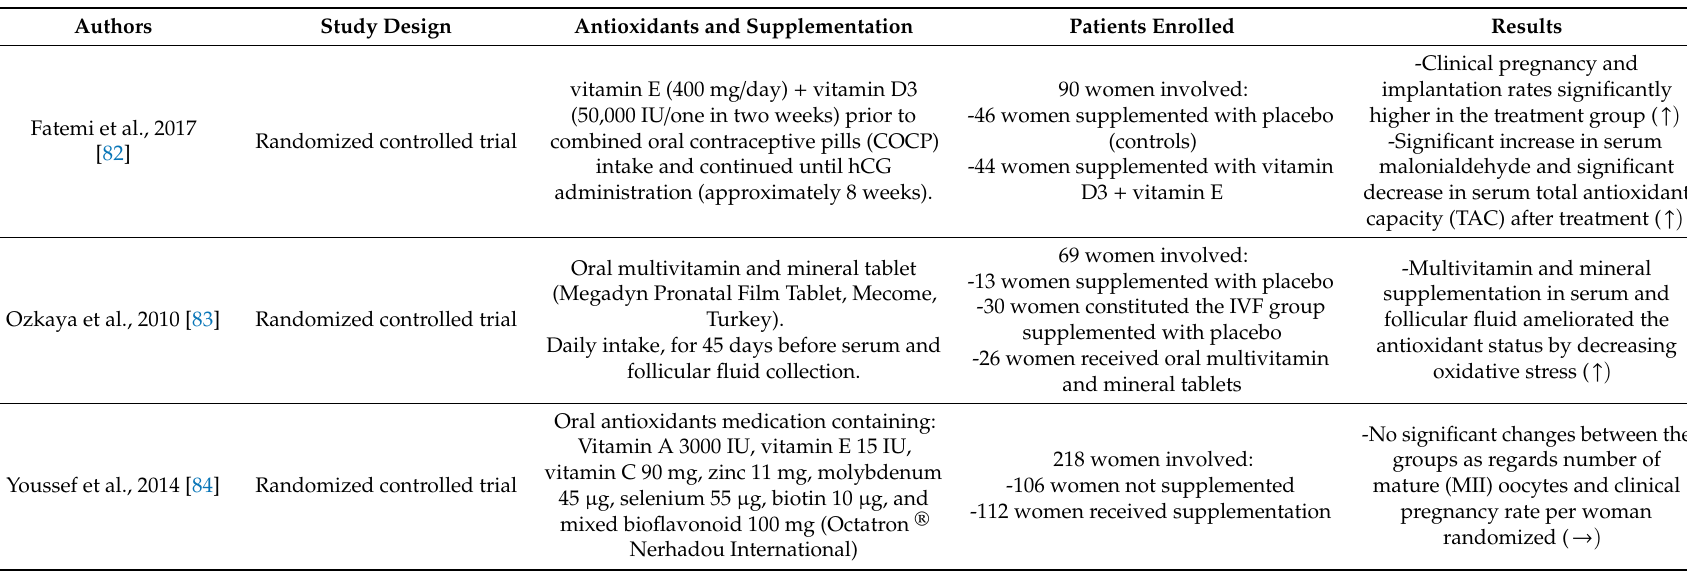
Table 4. Human clinical studies about antioxidants and multivitamins in combination during COS for IVF